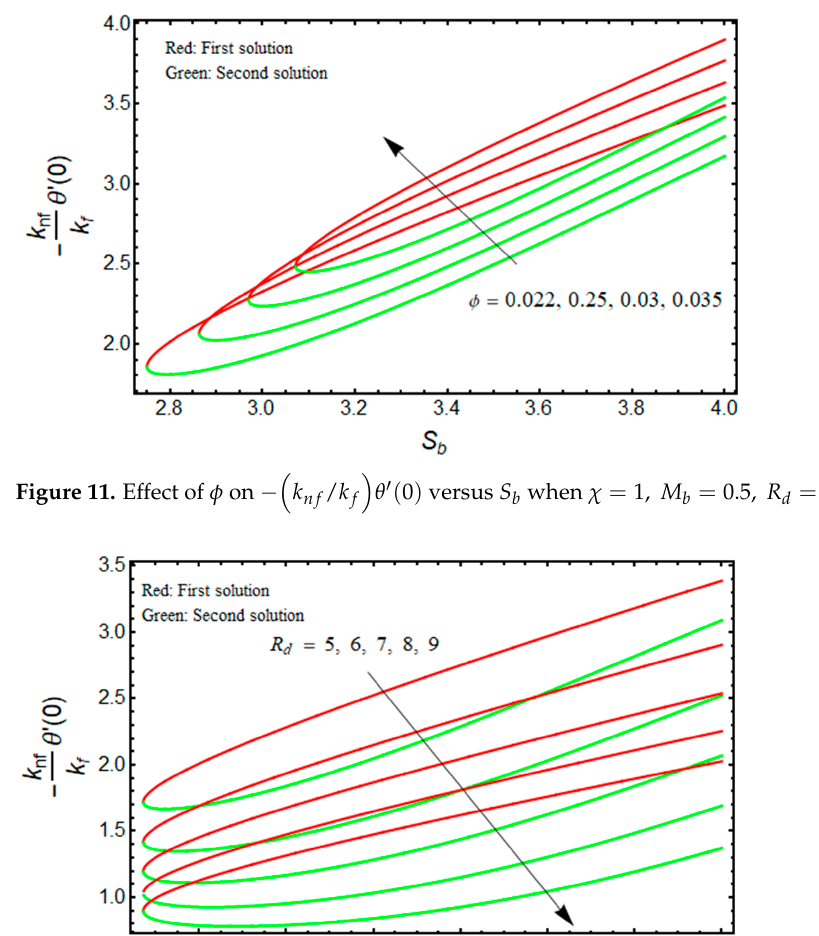
(cid:16) (cid:17) k nf / k f θ (cid:48) ( 0 ) versus S b when φ = 0.025, χ = 1, M b = 0.5, m = 1.